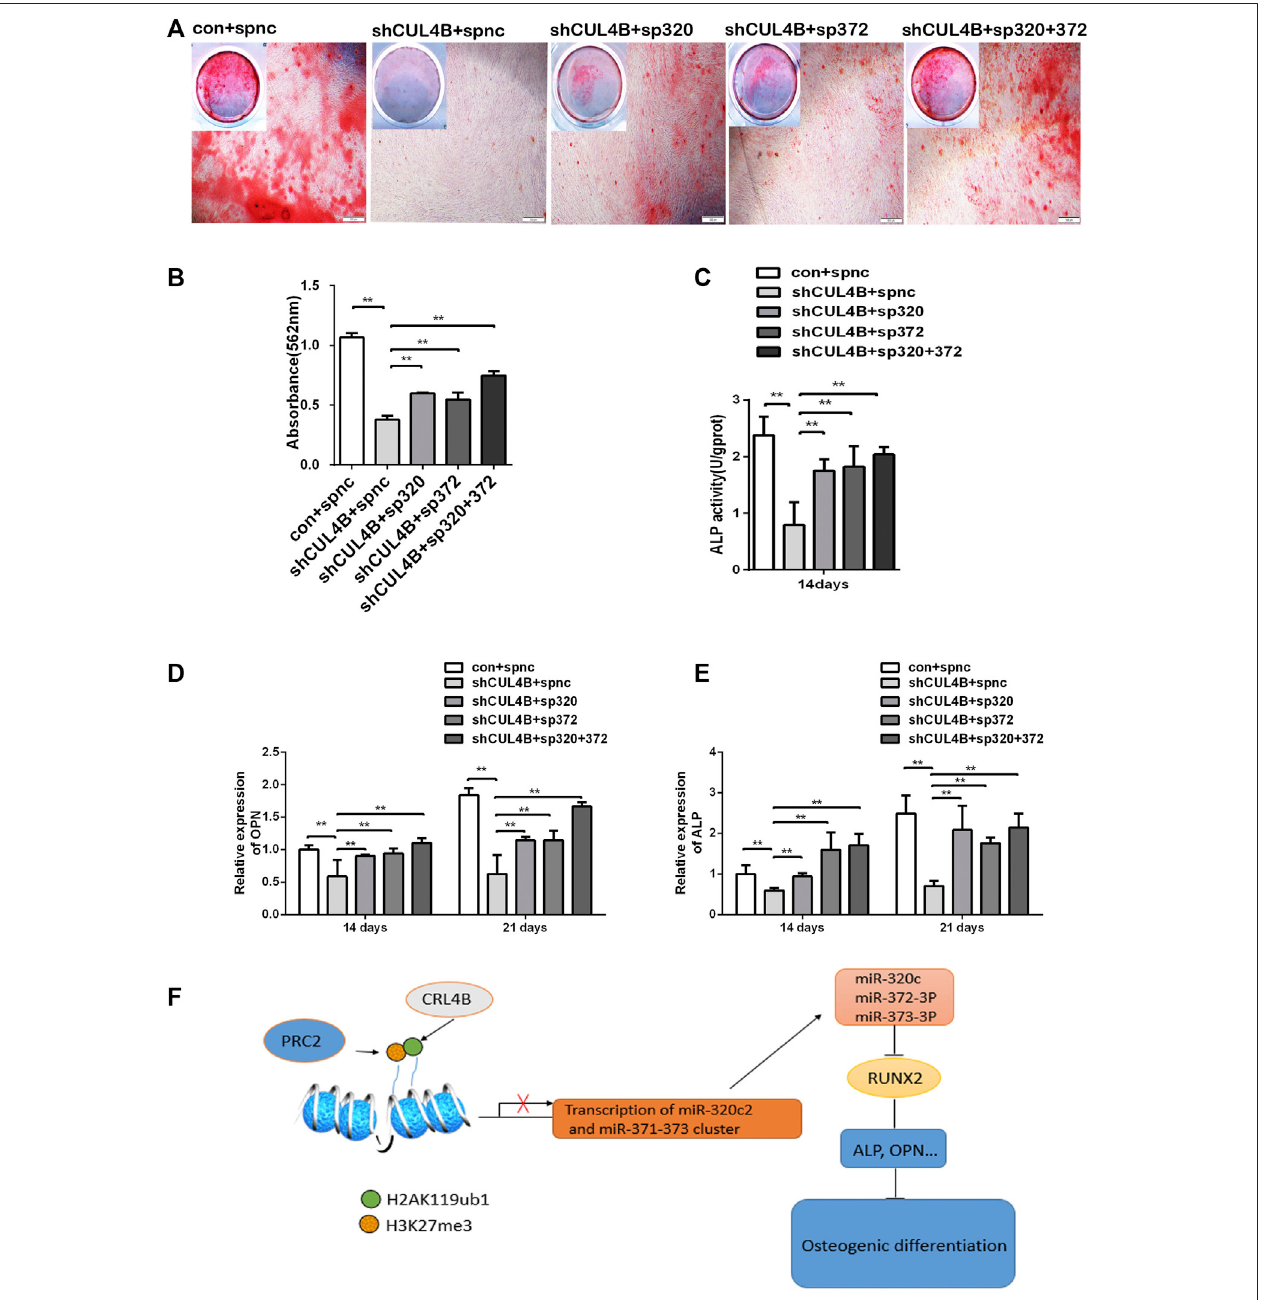
FIGURE 6 | CUL4B regulates the osteogenic differentiation of PDLSCs via the miR-320c and miR-372-3p/373-3p-RUNX2 axis. (A – E) CUL4B stable knockdown (shCUL4B) or control (con) PDLSCs were infected with lentivirus carrying: miR-320c sponge (sp320c), miR-372-3p/373-3p sponge (sp372) or control sponge (spnc), after which the infected cells were cultured in osteogenic induction medium for 14 or 21 days. At 21 days, the cells were collected for Alizarin Red staining (A) and analysisoftheconcentrationofcalciumdeposition (B) .Scalebars:200 μ m. (C) ALPactivityofdifferentgroupsofPDLSCswereanalyzedatday14.Theexpression ofosteogenesis-relatedgenesOPN (D) andALP (E) indifferentgroupsofPDLSCscollectedatday14weredeterminedbyqRT-PCR. (F) SchematicoftheCUL4B-miR- 320c and miR-372/373-RUNX2 axis and its role inthe regulationof PDLSC osteogenesis. All quanti fi cation analyses werebased on independent triplicate experiments. Error bars represent SD. Statistical comparisons were made using a two-tailed unpaired t-test, * p < 0.05, ** p < 0.01 compared with the negative control.